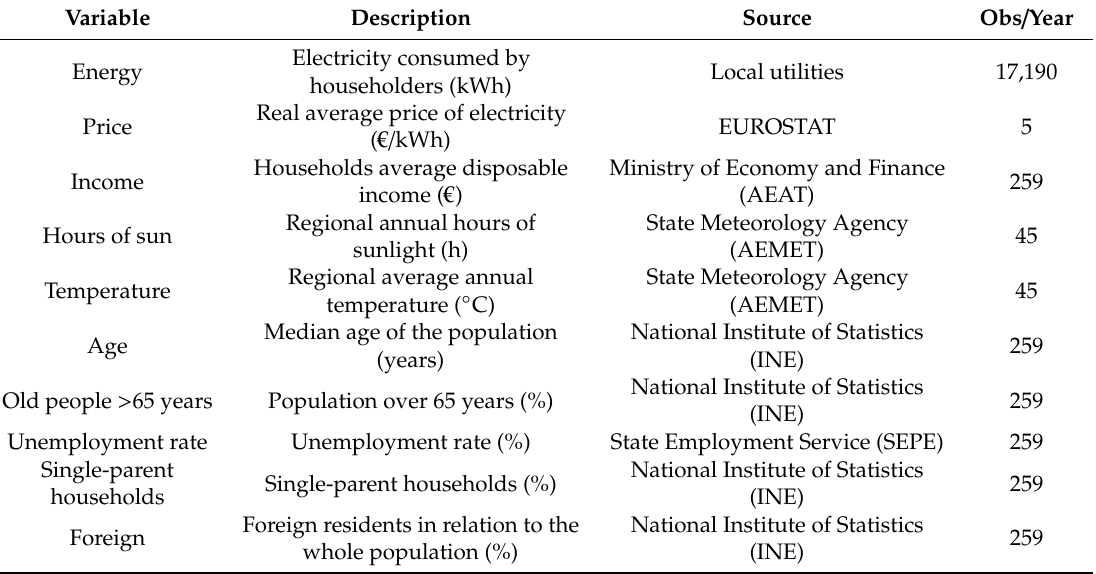
Table 2. Description of data sources.